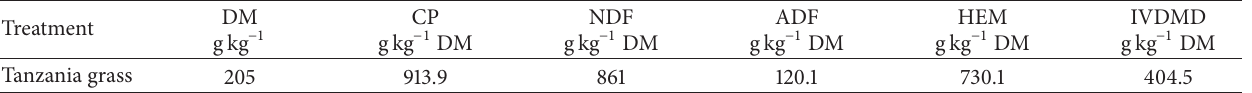
Table 4: Chemical composition and in vitro digestibility of Tanzania grass before ensiling. Treatment